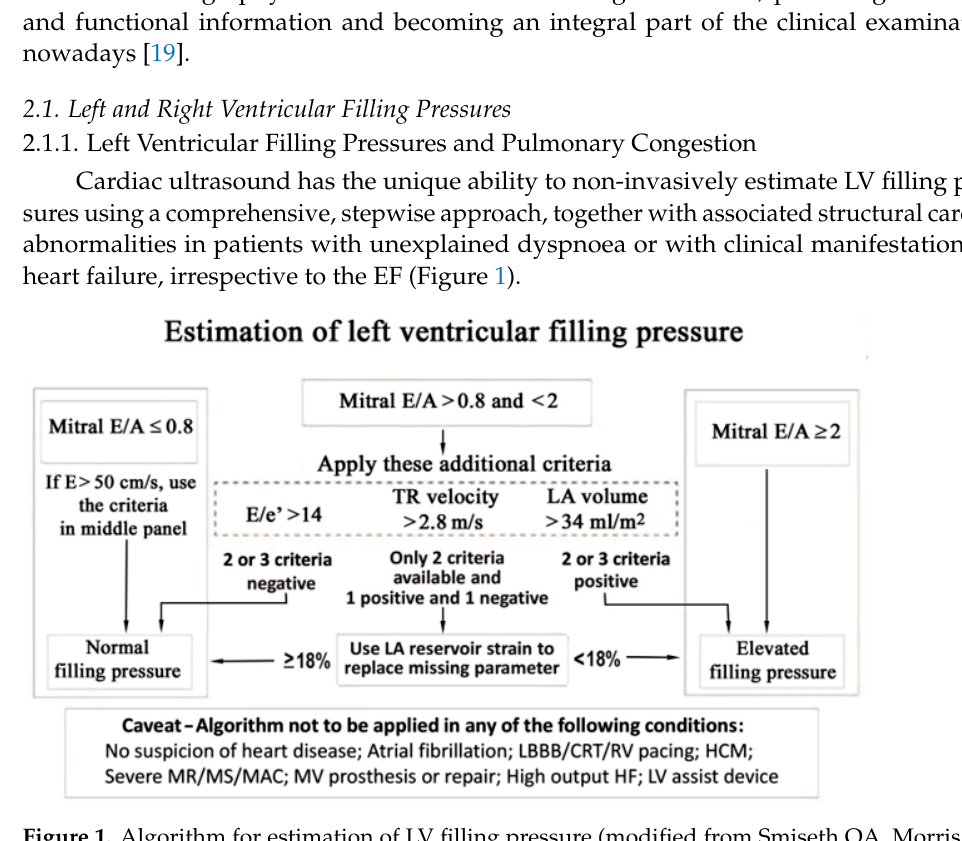
Figure 1. Algorithm for estimation of LV filling pressure (modified from Smiseth OA, Morris DA, Cardim N, et al. Multimodality imaging in patients with heart failure and preserved ejection fraction: an expert consensus document of the European Association of Cardiovascular Imaging. Eur. Heart J. Cardiovasc. Imaging. 2022, 23(2), e34–e61. doi:10.1093/ehjci/jeab154. PMID: 34729586. [20]). A =